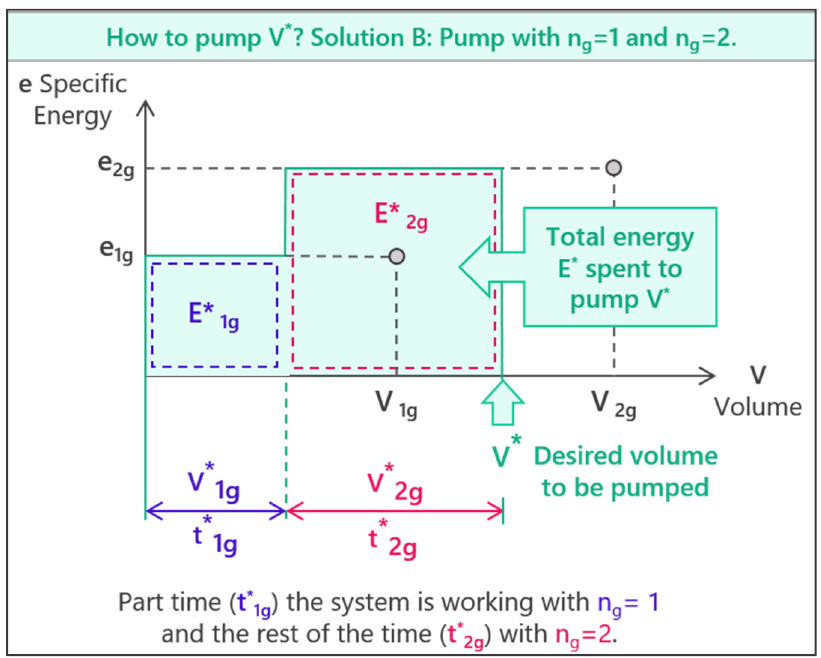
Figure 5. Solution B. Combine the number of pumps.